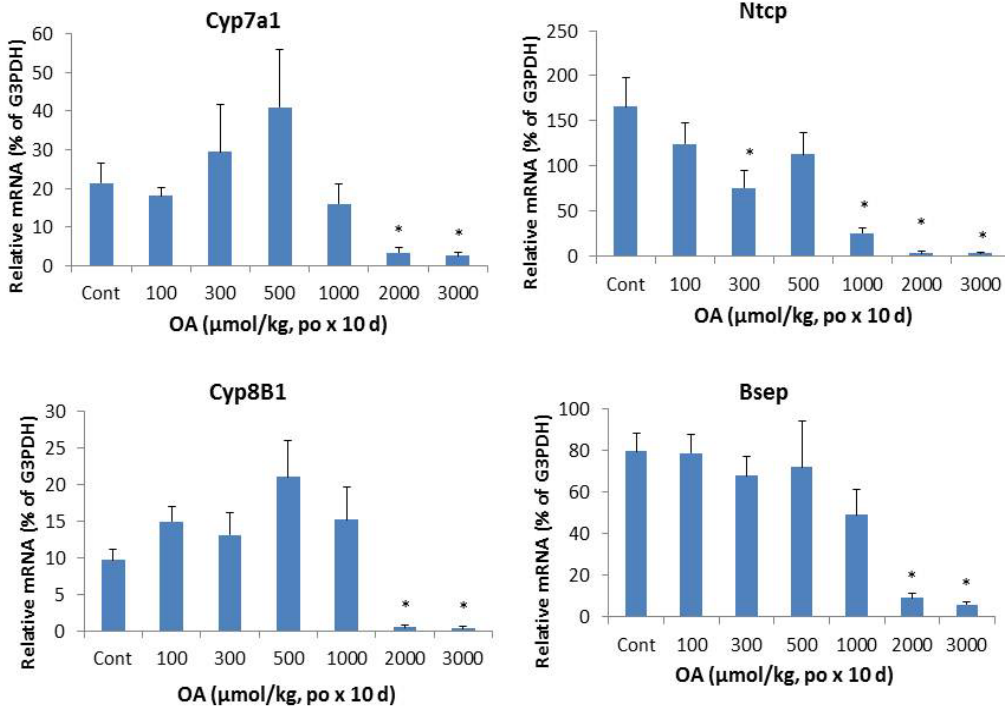
Figure 5. Effect of oral OA on expression of bile acid synthesis and transport genes. Mice were gavaged OA at doses of 100–3,000 µmol/kg (equal to 45–1,350 mg/kg). Twenty-four hours after the last dose, Livers were collected to isolate total RNA. The expression of hepatic transport genes were determined by real-time RT-PCR as detailed in the